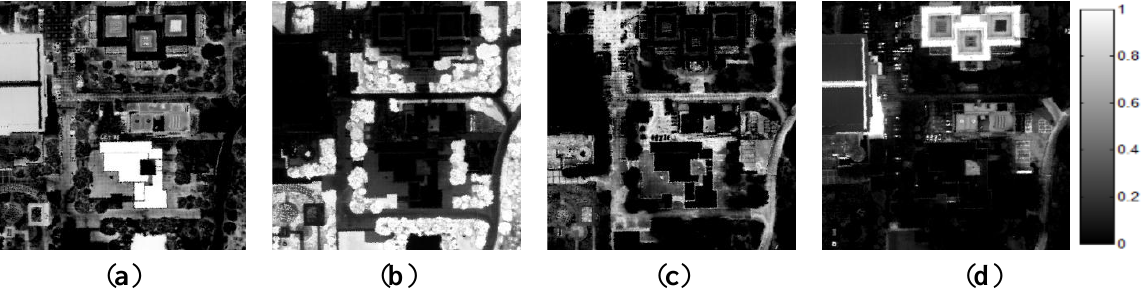
Figure 7. Abundance maps of ground-truth materials in the CASI data. ( a ) Water; ( b ) Vegetation; ( c ) Roads; ( d )